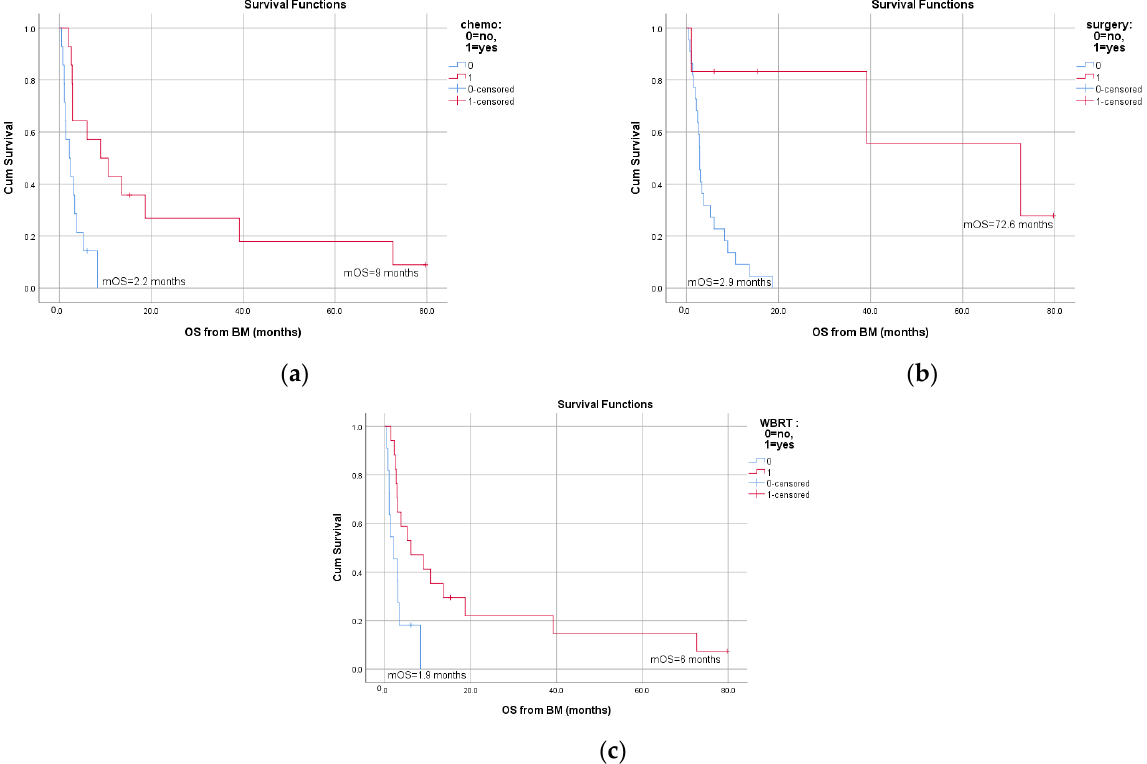
Figure 3. Overall survival (OS) from brain metastases according to ( a ) chemotherapy, ( b ) surgery and ( c ) whole-brain radiation therapy (WBRT).